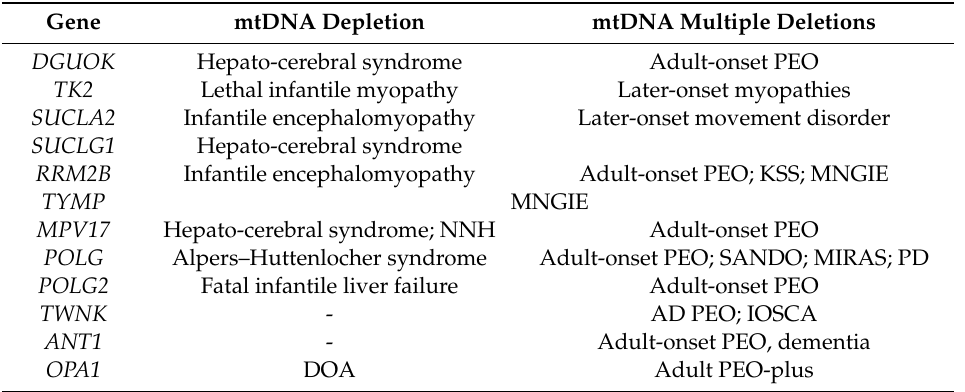
Table 1. Intergenomic defects. Summary of multiple mendelian genetic defects a ff ecting mtDNA integrity, causing—in various combinations—mtDNA depletion and mtDNA multiple deletions. Acronyms are explained in the